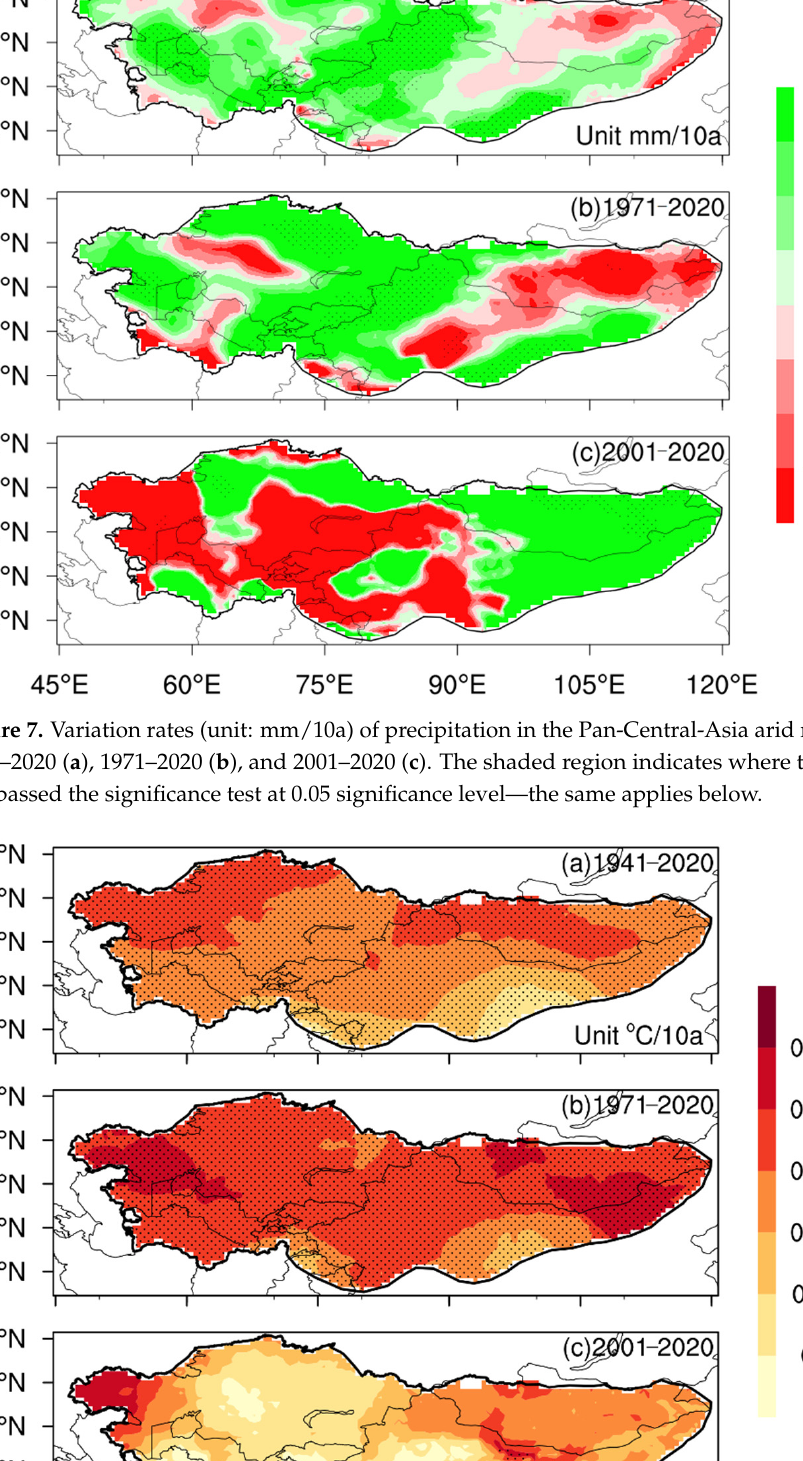
Figure 9. Same as Figure 7, but for variation rates (unit: /10a) of AI ( a – c ). Figure 10 shows the first spatial mode and time series of the precipitation anomaly field (Figure 10a,b) and the temperature anomaly field (Figure 10c,d) derived from EOF decomposition. From 1941 to 2020, the first spatial mode of the precipitation anomaly field (variance contribution rate is 26.48%) was mainly dominated by negative values, indicat- ing that the overall variation was consistent. However, an anomaly center near Tajikistan, Kyrgyzstan and Tianshan Mountains indicates that precipitation in these regions changed